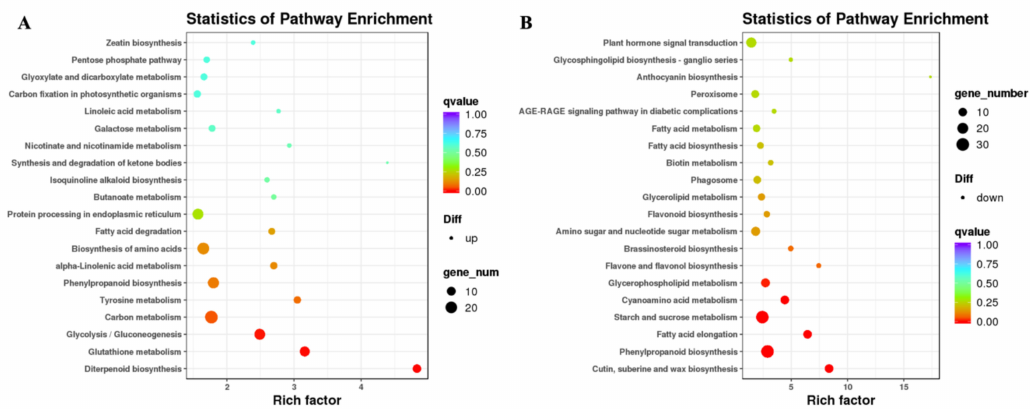
Figure 4. Kyoto Encyclopedia of Genes and Genomes (KEGG) pathway enrichment analysis based on the di ff erentially accumulated genes in control and PHI-treated rice seedlings. Up-regulated genes ( A ) and down-regulated genes ( B ).